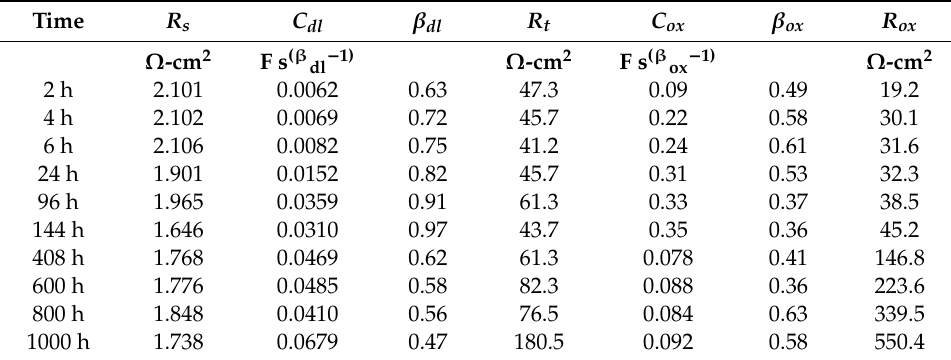
Figure 15. Nysquist diagram of VM12 layer in LiNaKNO 3 (ternary salt with lithium content) of 1000 h at 2 h, 4 h, 6 h, 24 h, 96 h, 144 h, 408 h, 600 h, and 1000 h at 550 °C. Table 10. Fitting results of the impedance spectra of VM12 during corrosion in the presence of (LiNaK)NO 3 (ternary salt with lithium content) at 550 °C.